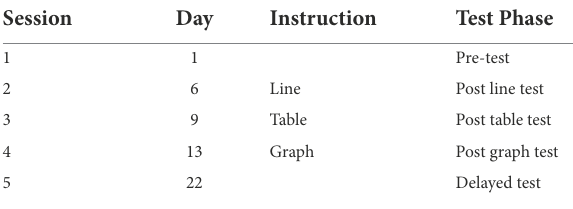
TABLE 3 Summary of the multiple baseline design. All five test phases contained a Compare quantities, a Predict patterns, and a Compare trajectories